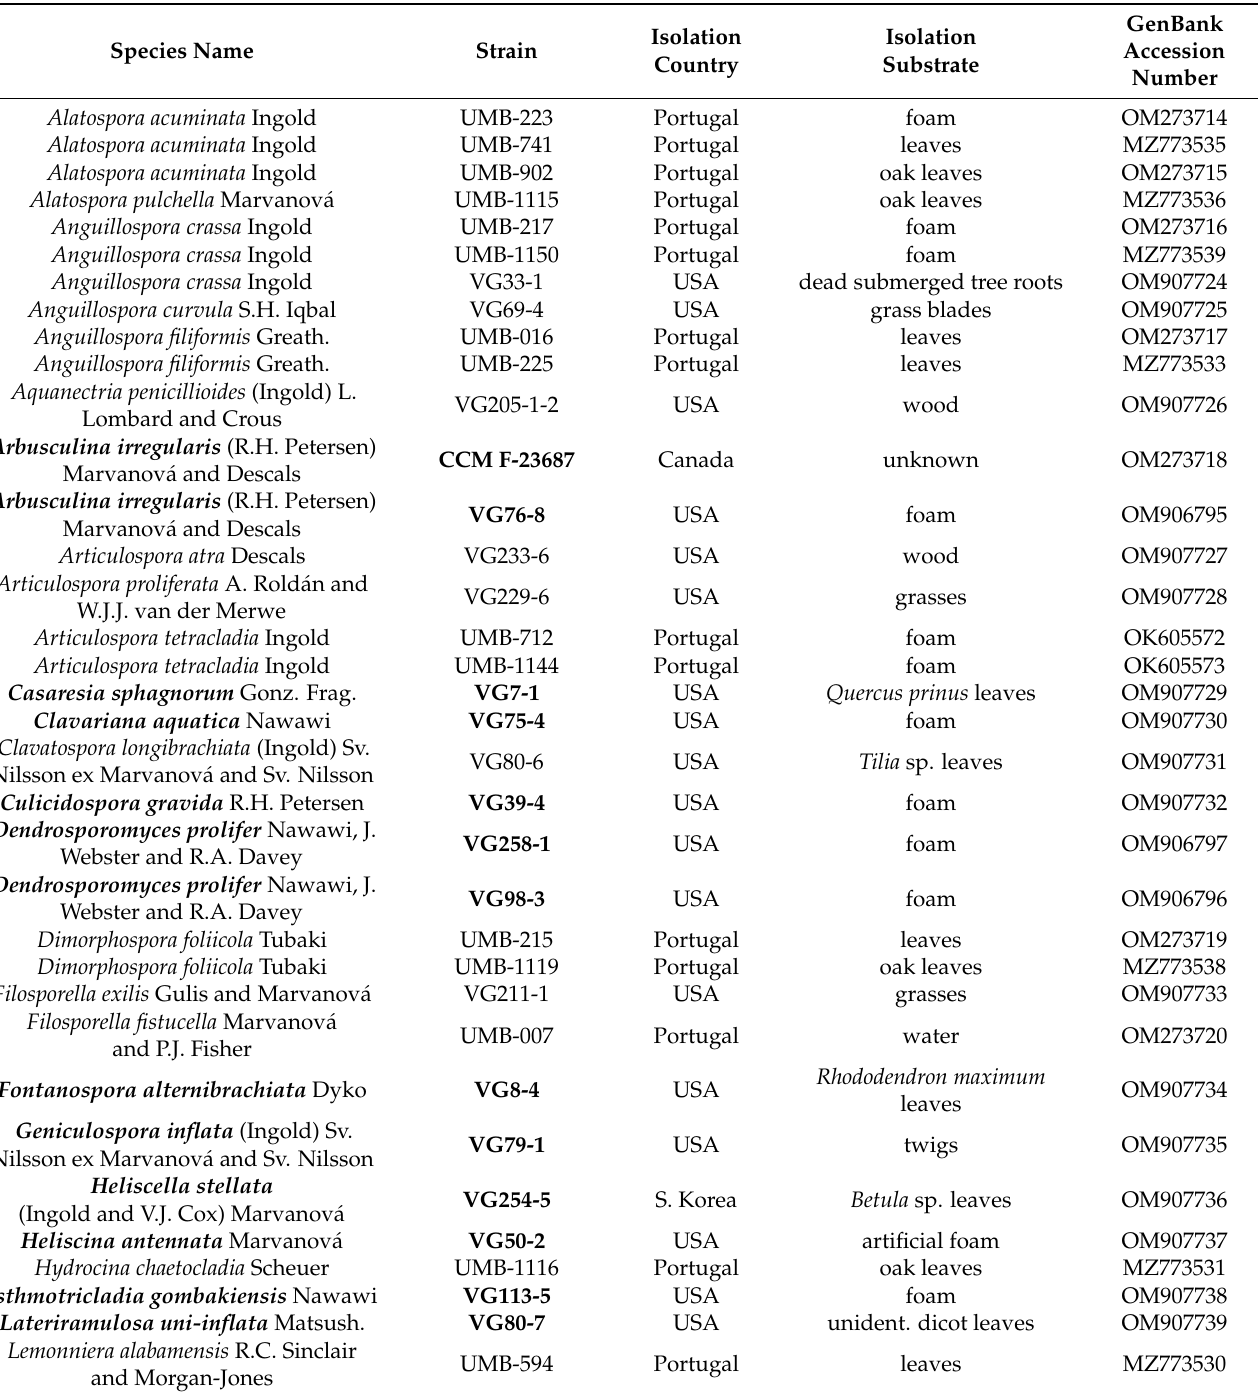
Table 1. Sources and accession numbers of aquatic hyphomycete isolates sequenced in this study. Species with new ITS barcodes generated for the first time in this study are highlighted in